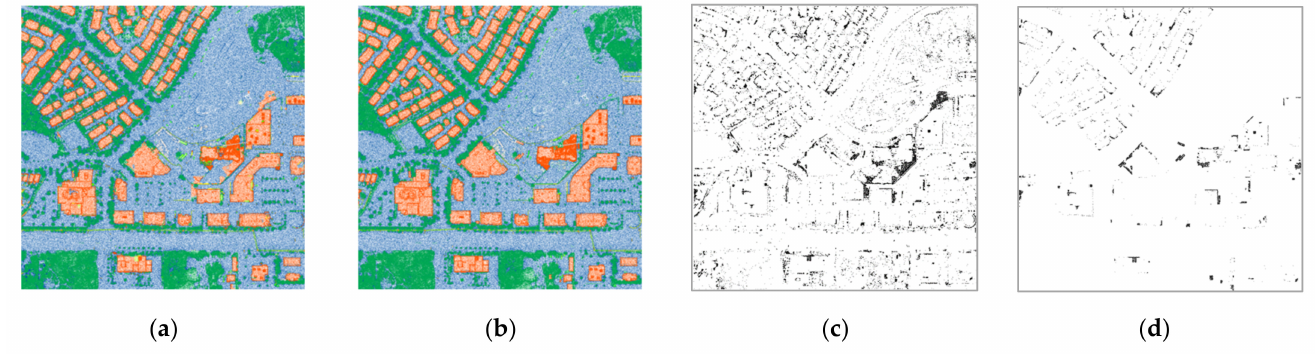
Figure 17. Results of semantic segmentation of test data 1 for Case 2: ( a ) prediction; ( b ) ground truth (i.e., label data); ( c ) difference between prediction and ground truth for all classes; ( d ) difference between prediction and ground truth for building class only.